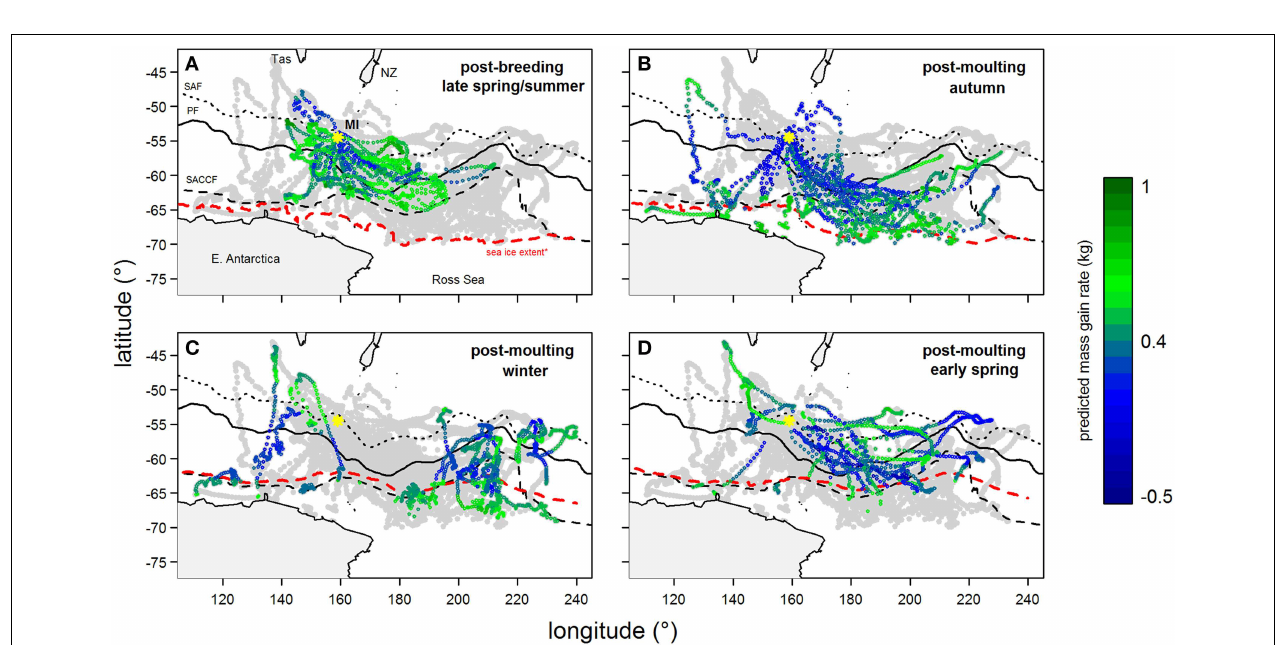
FIGURE 4 | Tracks of southern elephant seals (from Macquarie Island) during their (A) summer and (B–D) winter foraging trips after the correction of geo-locations using state-space models (excluding locations in heavy sea ice). Year-round location points are light-gray and are overlaid with predicted mass gain values from our foraging success model (see legend for color code) according to season. Maps show the bottom of Tasmania (Tas) and New Zealand